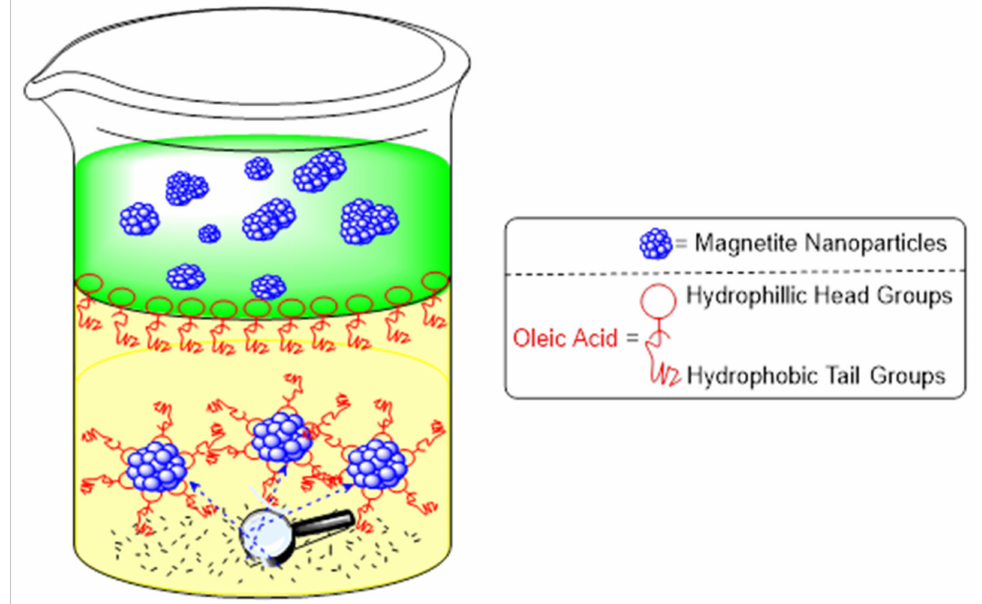
Figure 3. Schematic representation of phase transfer via modification with oleic acid ligands. The scheme is derived from